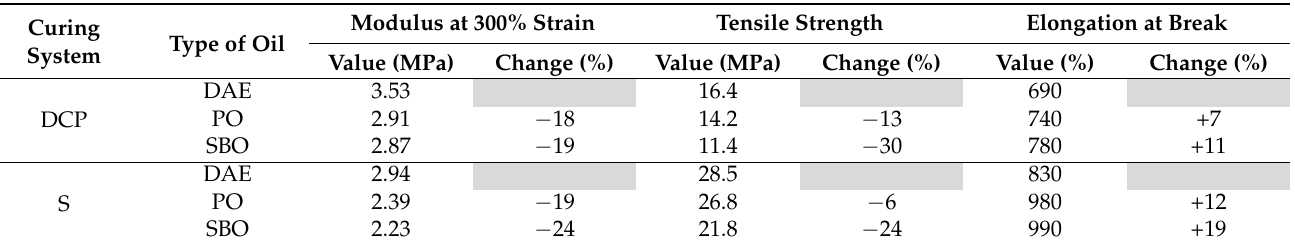
Table 2. Tensile properties, i.e., modulus at 300% strain, tensile strength, and elongation at break, of rubber compounds cured with different curing systems and change on the properties of rubber compounds containing bio-oils compared to